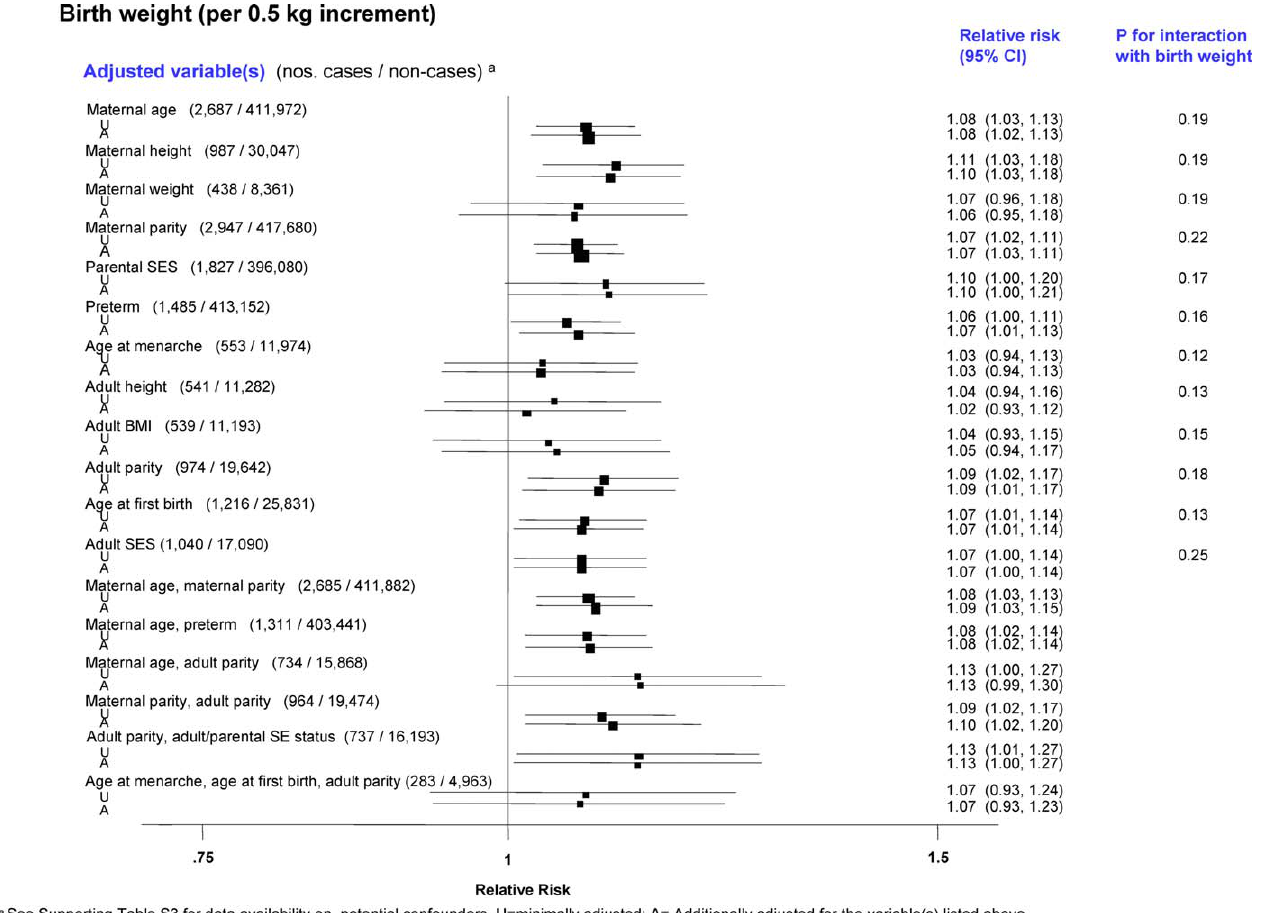
Figure 5. Pooled Breast Cancer RRs, Minimally Adjusted and Further Adjusted for Various Potential Confounding Factors in Relation to Continuous Birth Weight (Restricted to Singleton Studies Based on Birth Records) Adjustments for maternal age (continuous), maternal height (continuous), maternal weight (continuous), maternal parity (categorical: 0, 1, 2, (cid:2) 3), parental SES (study-specific categories: paternal SES for Medical Research Council National Survey of Health and Development [MRC NSHD]; maternal SES for Saint Olav’s University Hospital Birth Cohort [SOUHCB], Trondheim & Bergen Population-based Case-Control Study [TBPCCS], and Swedish study on Pre-Natal Factors and Breast Cancer [SPNFBC]; and parental/paternal occupation for Carolina Breast Cancer Study [CBCS]), preterm (binary), age at menarche (categorical: , 12 y, 12.0–12.9 y, (cid:2) 13 y), adult height (continuous), adult BMI (continuous), adult parity (categorical: 0, 1, 2, (cid:2) 3), age at first birth (categorical: nulliparous, , 20 y, 20–29 y, (cid:2) 30 y), and adult SES (study-specific categories: adult SES for MRC NSHD, Helsinki Birth Cohort Study [HBCS] I, Population Study of Women in Gothenburg [PSWG]; and occupation for Malmo¨ Diet and Cancer Study [MDCS]).